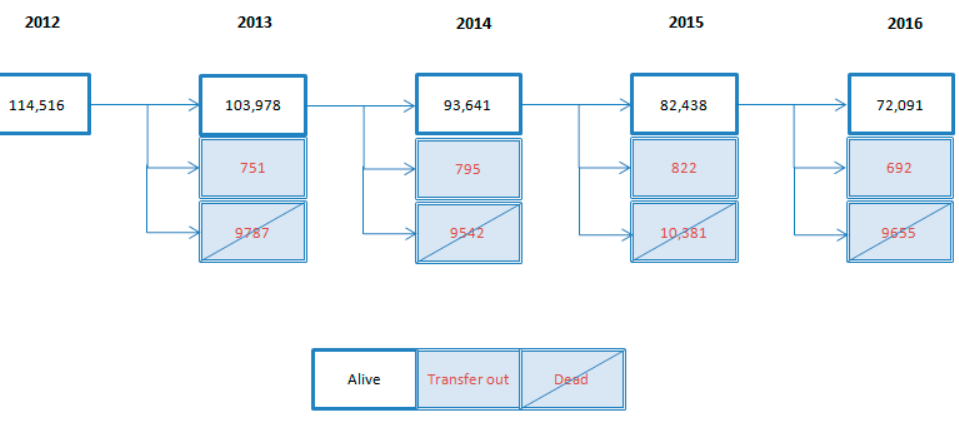
Figure 2. Longitudinal flow chart of study period (year 2012–2016; N = 114,516 persons). At baseline, the people included were mostly men (59.6%), with a mean age of 78.8 years (SD 7.4) and a high prevalence (83.5%) of polypharmacy. At baseline versus study end, respectively, participants had a median of 9 (IQR 7-11) versus 10 (IQR 9-13) chronic diseases, were taking a median of 8 (IQR 6-11) medications (stable over the study period) and visited PHC annually a median of 17 (IQR 9-28) versus 18 (IQR 10-30) times (Table 1).